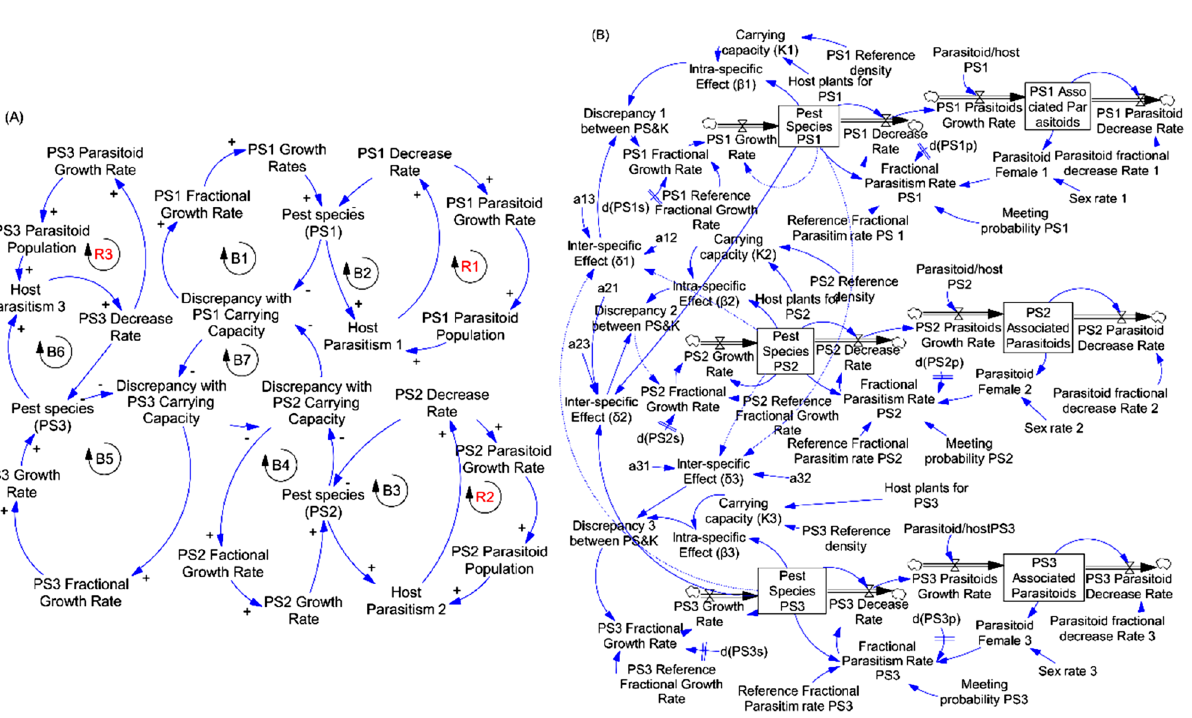
Figure 6. Causal loops ( A ) and flow diagram ( B ) of three pest species and its parasitoids and the resource in the